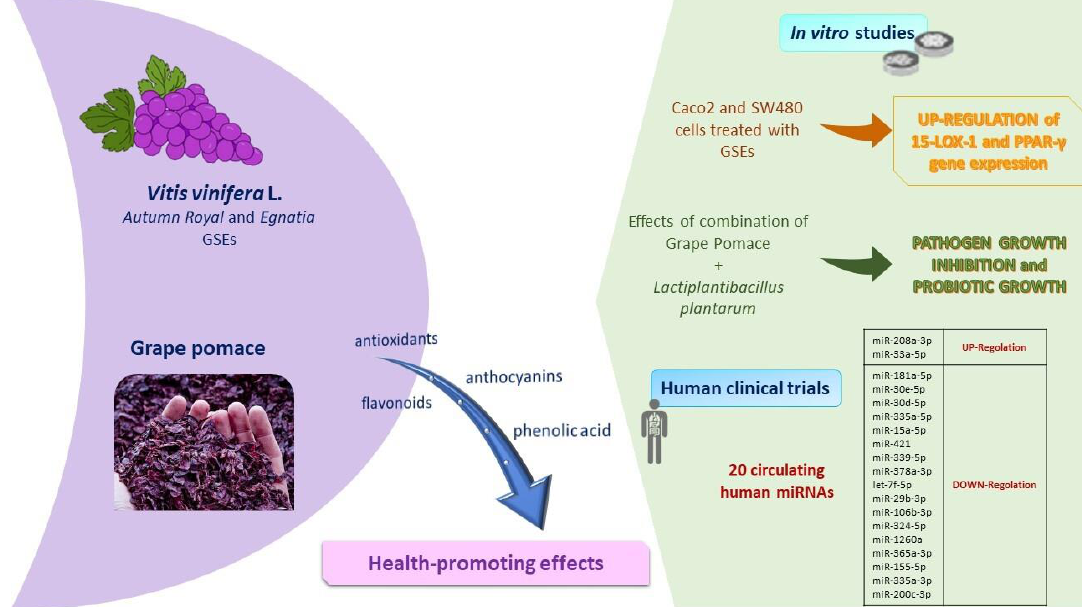
Figure 4. Main features of fruit components: summary of in vitro and in vivo studies performed on Vitis vinifera L. and grape pomace. Abbreviations: 15-LOX-1, 15-lipoxygenase-1; GSEs, grape skin extracts; miRNAs, microRNAs; PPAR- γ, peroxisome prolife rator-activated receptor- γ.